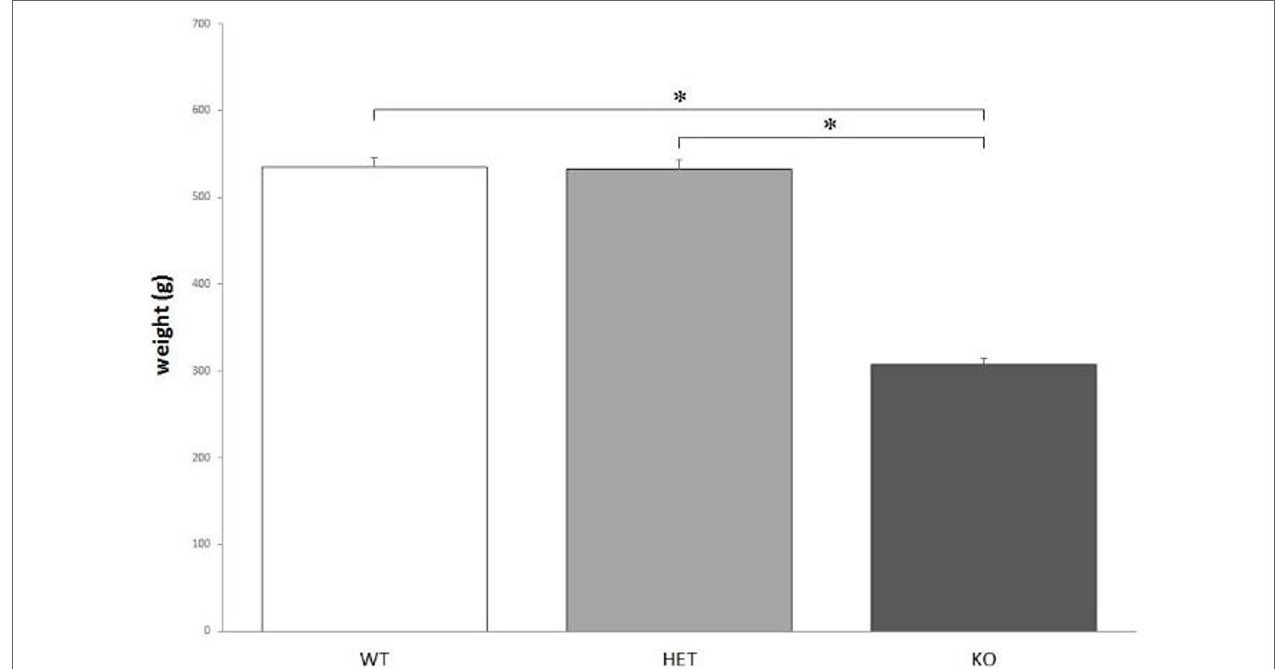
FigUre 1 | The average body weight measured for the three genotypes. Knockout (KO) rats weigh significantly less when compared to both wild-type (WT) and dopamine transporter–heterozygous (HET) rats. * P <